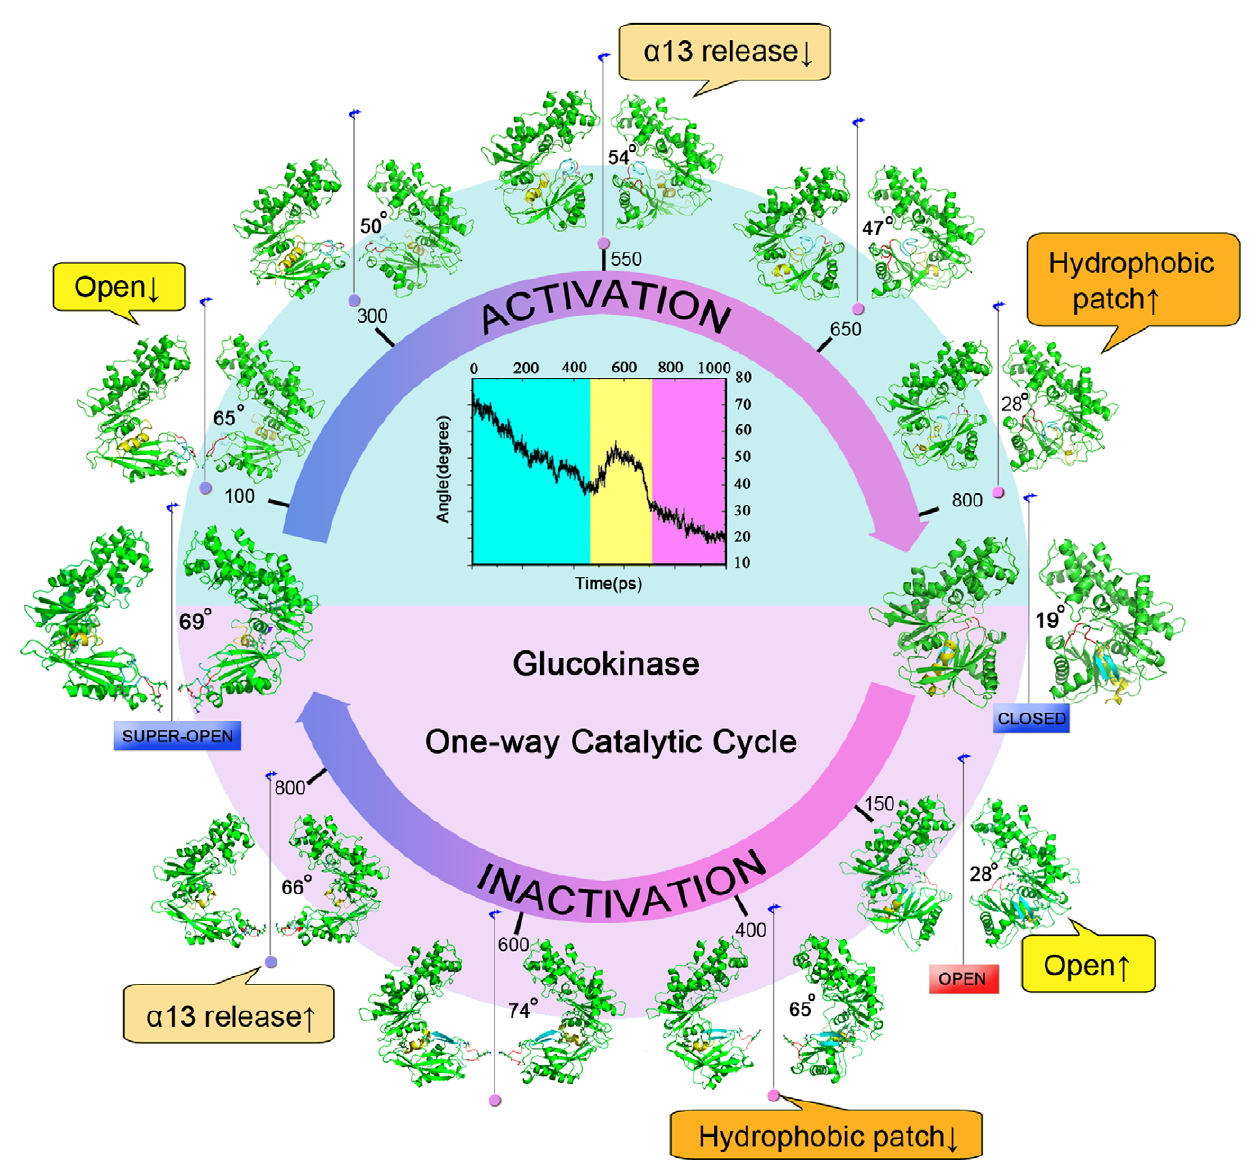
Figure 3. The conformational transition pathway of GK between the super-open state and the closed state. The center image is the time dependence of the cleft angle between the two domains in the process of GK activation. Around the upper semicircle of the center image, five snapshots are extracted from trajectory B1 at the activated times of 100 ps, 300 ps, 550 ps, 650 ps and 800 ps. Two crystal structures of GK in the super-open and closed states are shown at either end of the catalytic cycle, and four snapshots at the inactivated times of 150 ps, 400 ps, 600 ps and 800 ps that were found previously are also shown in the lower semicircle (9). Three important components of conformational change in GK are labeled in comment frames. Loop I between the a 4 and b 7 segments is in red; the b 6 and b 7 strands are in cyan; helix a 13 is in